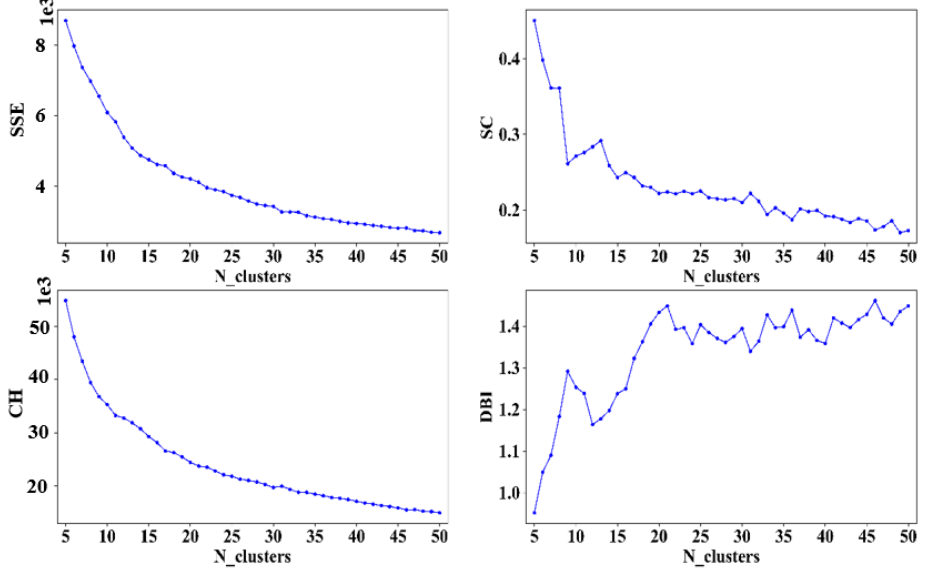
Figure 6. Selection of K for arrival aircraft.